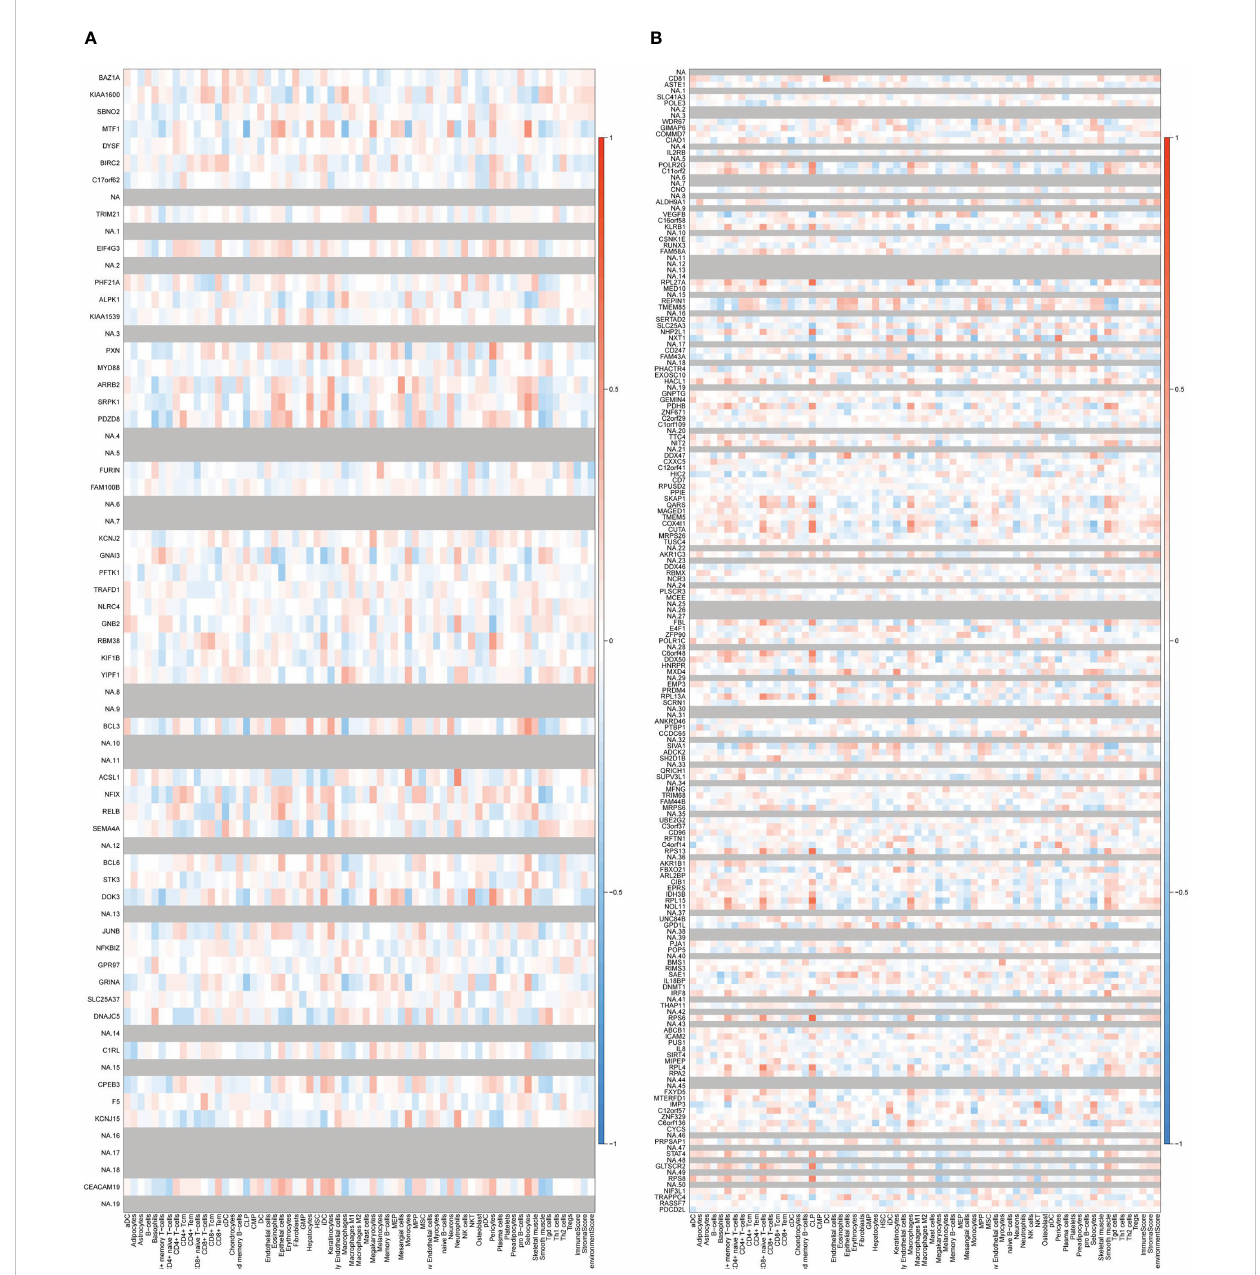
FIGURE 12 Correlation between up-regulated and down-regulated coDEGs and immune cells in RA datasets (A) Correlation between up-regulated coDEGs and immune cells in RA(GSE17755). (B) Correlation between down-regulated coDEGs and immune cells in RA (GSE17755). (Gray means that the gene was not probed in this